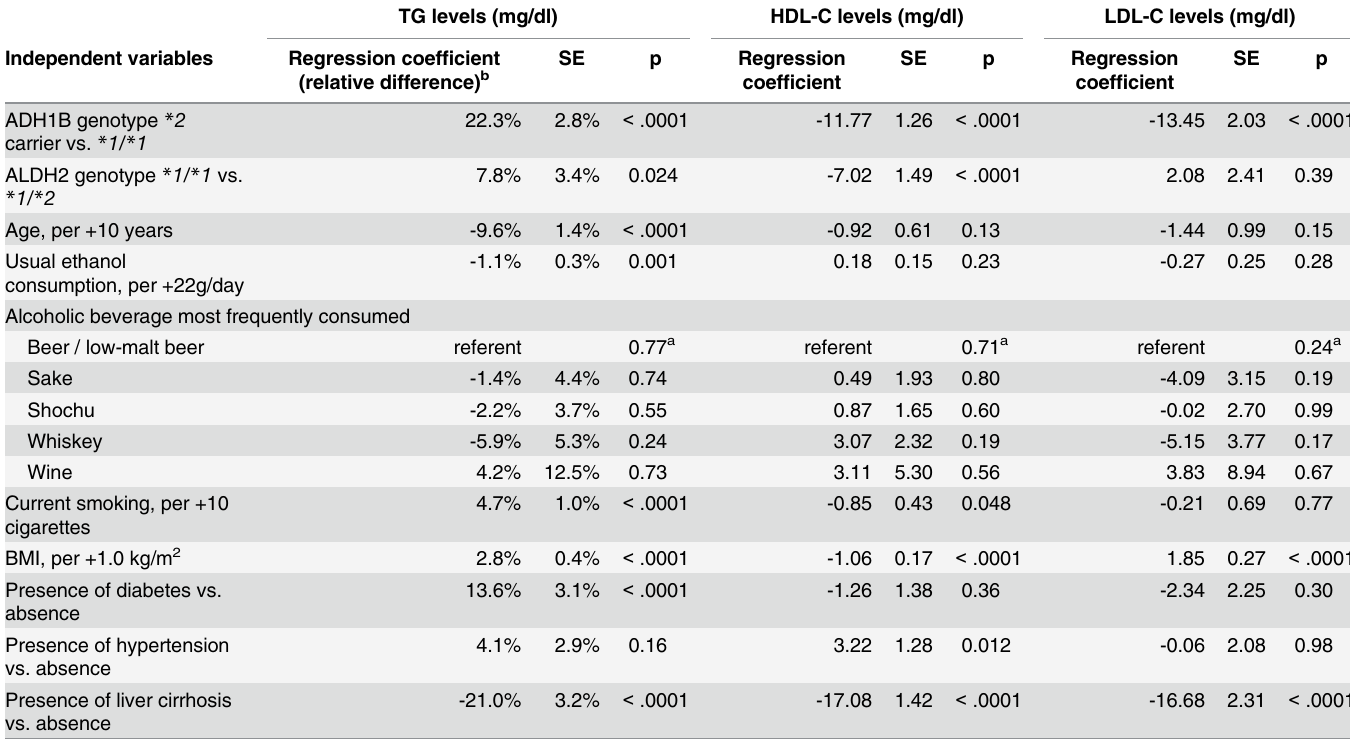
Table 3. Multiple linear regression analysis to predict serum lipid levels of Japanese alcoholic men.